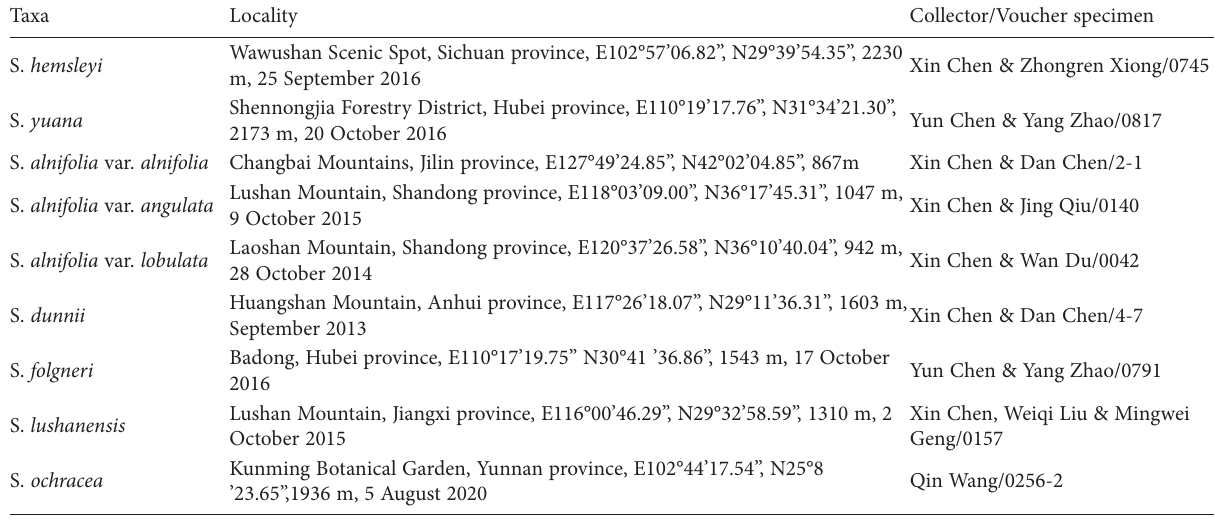
Table 1. Localities and voucher specimens of Sorbus taxa examined in the present